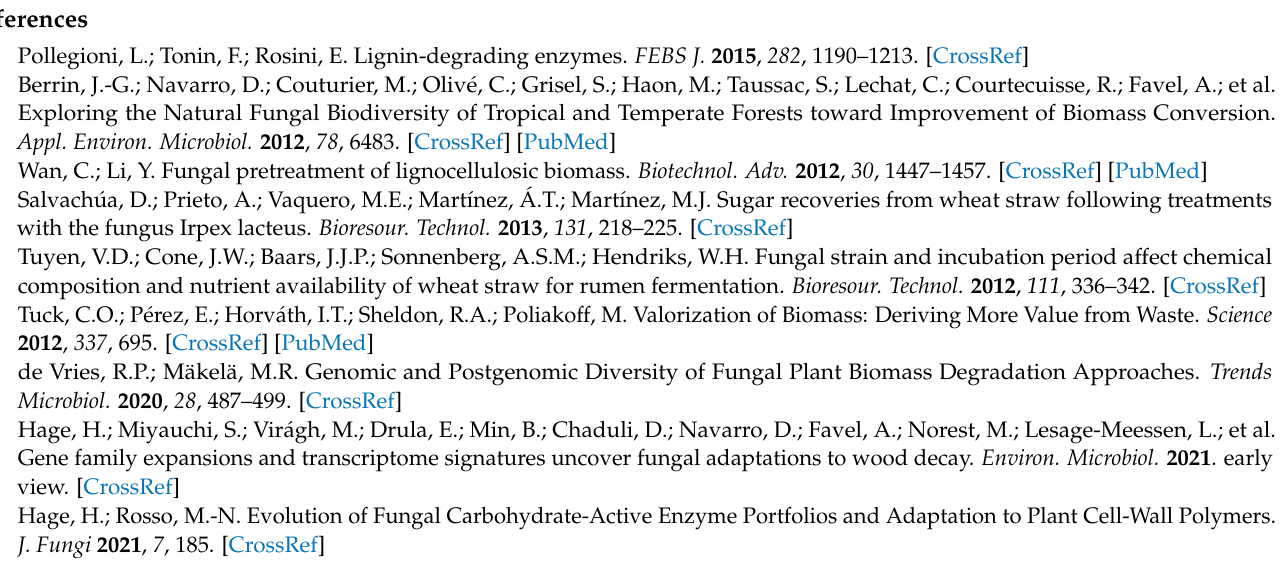
on the different tested substrates, Figure S7: H2O2 production overtime in the reaction of Tr LOx on different substrates, Figure S8: LC-MS chromatograms of the reaction of Tr LOx on Syringol and Syringyl alcohol. Table S1: Total phenolic and thioacidolysis yields of water-insoluble residual lignin after exposure to T. reesei, Table S2: Identified CAZymes in the secretomes during growth of T.